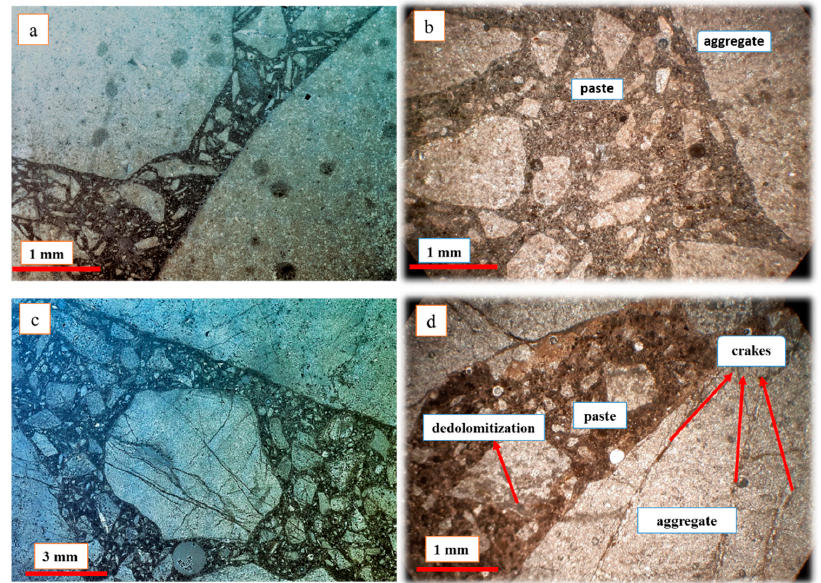
Figure 12. Optical microscopy photograph: ( a ) granite concrete after 1 month; ( b ) granite after 6 months; ( c ) rhyodacite concrete after 6 months with non-polarized light; ( d ) rhyodacite aggregate after 6 months (gel-like materials are seen in the polarized light).